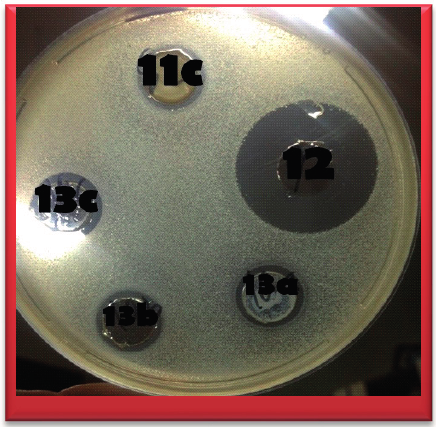
Figure 2. Examples of some activities for compounds 11c , 12 , 13a , 13b and 13c against Bacillus subtilis